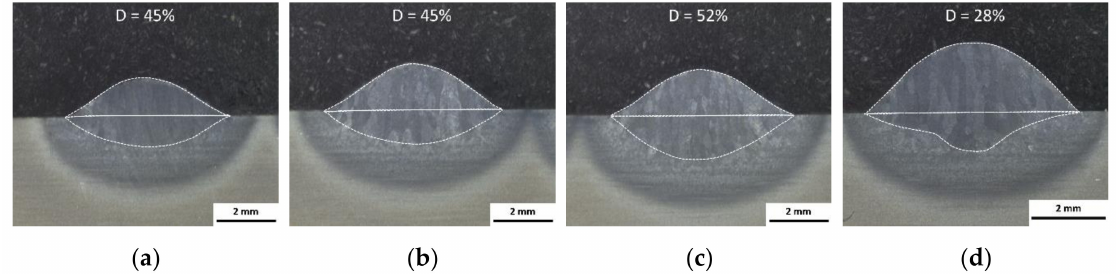
Figure 3. Dilution and geometric evolution of single beads deposited with di ff erent parameter configurations given in Table 4. Dilution: ( a , b ) 45%, ( c ) 52% and ( d ) 28%.